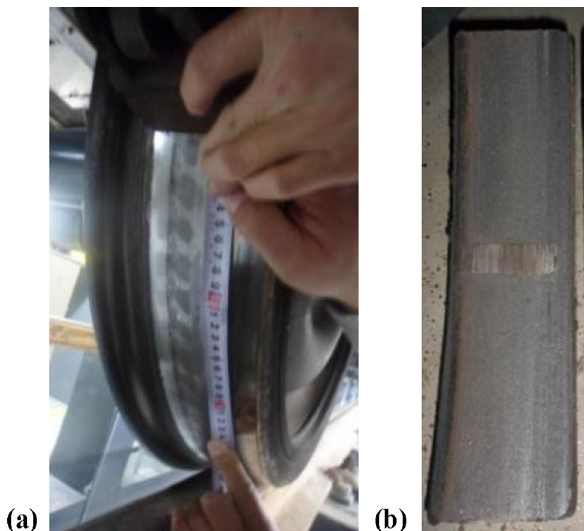
Fig. 3 a Wheel corrugation with a wavelength of approximately 30 mm on a type-B metro train with a maximum operating speed of 80 km/h equipped with tread brakes using the b repair compound